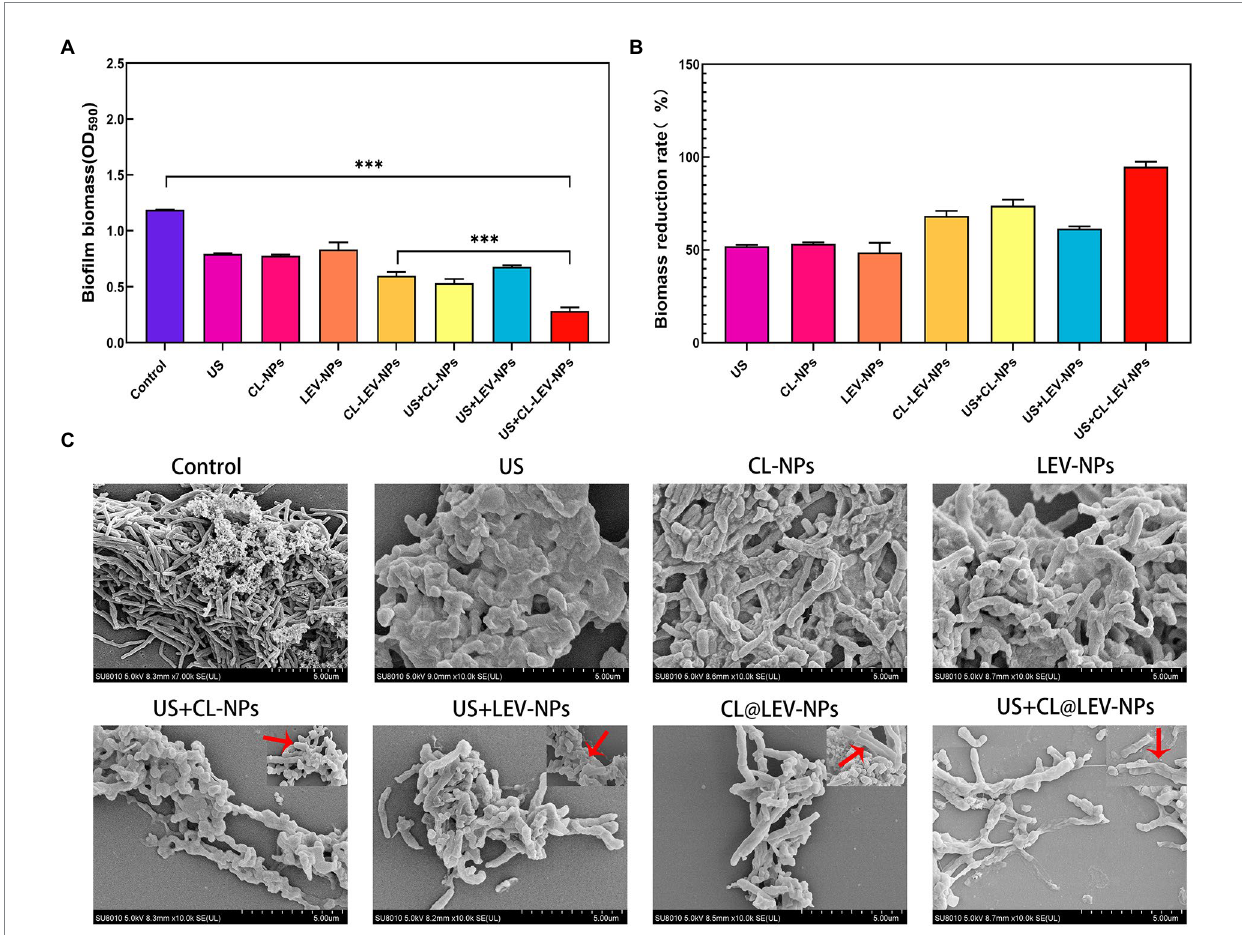
FIGURE 6 Antibacterial activity of BCG biofilms in vitro . (A) The quantification of the relative biomass of BCG biofilms after different treatments methods, *** p < 0.001; (B) Quantitative analysis of the reduction rate of BCG biofilm after different treatments, biofilm reduction rate = ( 𝑂𝐷 590,Control − 𝑂𝐷 590,Test )/ ( 𝑂𝐷 590,Control ) × 100%; (C) Typical SEM images of the structural changes of BCG biofilms after different treatments (×10 k). The red arrow indicates the enlarged detail picture (magnificaction,× 20